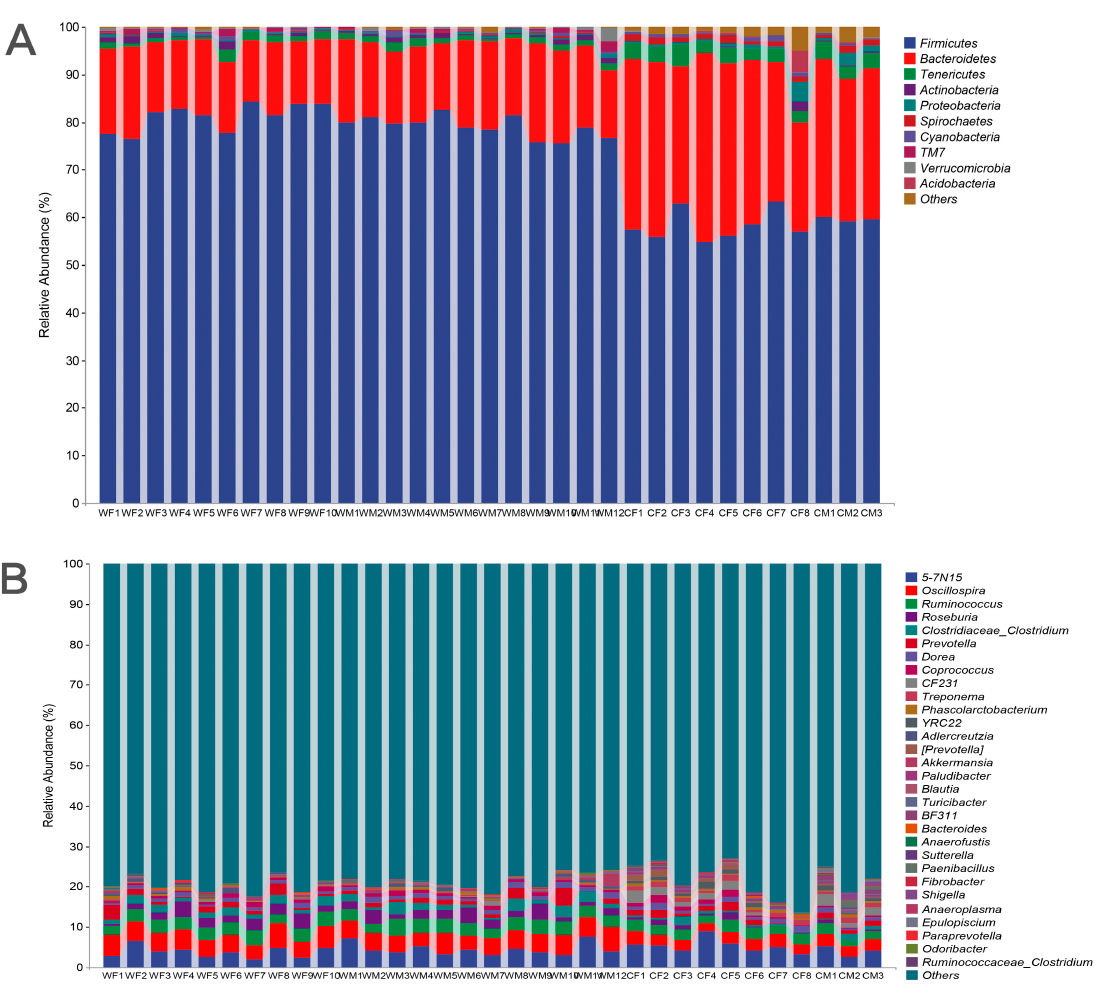
Figure 1. Relative abundance of the top 10 bacterial phyla and top 30 genera present in the fecal microbiota of wild and captive red deer ( A ) at the phylum level and ( B ) at the genus level (WF: n = 10, WM: n = 12, CF: n = 8, CM: n = 3).